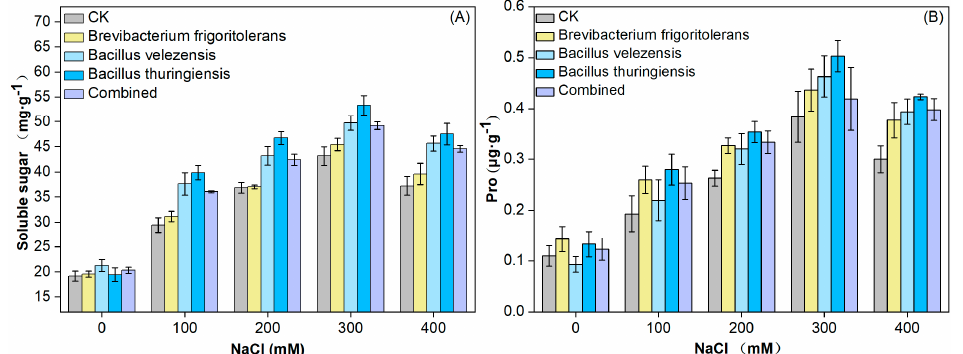
Figure 3. Effect of salt-tolerant plant growth promoting rhizobacterial (ST-PGPR) on wheat osmotic substances under NaCl stress: ( A ) soluble sugar and ( B ) proline (Pro).